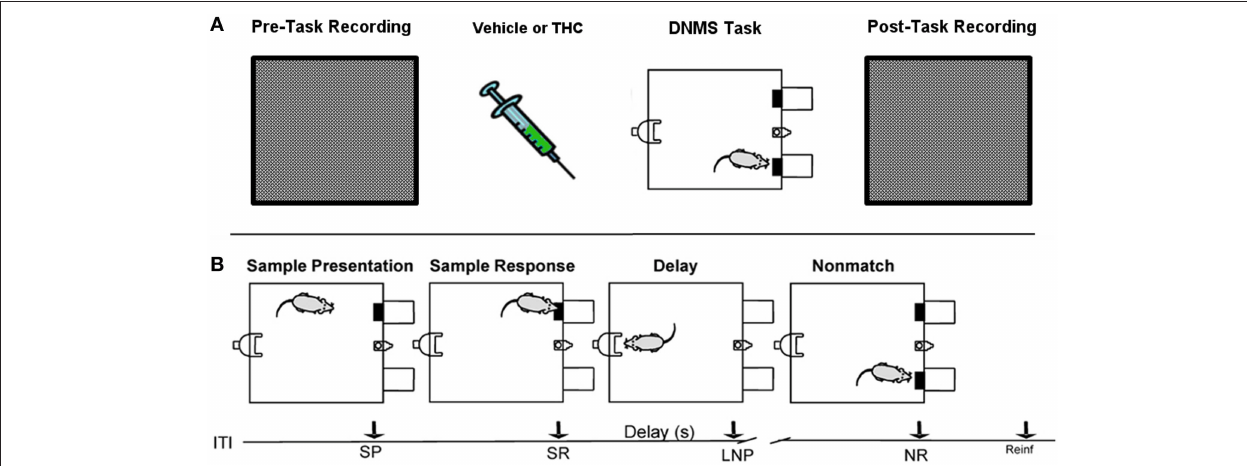
FIGURE 1 | Rest (pre/post) and Delayed Nonmatch-to-Sample (DNMS) task recording paradigm. (A) Prior to each testing session, all rats were recorded in a white, rectangular plastic box for 25–30min (pre-task recording). Upon completion of pre-task recording phase, the same rats were injected with either vehicle or delta-9-tetrahydrocannabinol (THC) 5–10min before the start of delayed nonmatch-to-sample (DNMS) task. Immediately after completing the DNMS task, rats were put back into the same plastic chamber for another 25–30min recording (post-task recording). (B) Progression of the DNMS task is illustrated. A 10s Intertrial Interval (ITI) precedes the Sample Presentation (SP). Rats must make the Sample Response (SR) and remember the lever position throughout the variable 1–30s delay that terminates after the Last Nosepoke (LNP). The LNP signals extension of both levers and rats receive a water reward (reinforcement) for appropriately making a Nonmatch Response